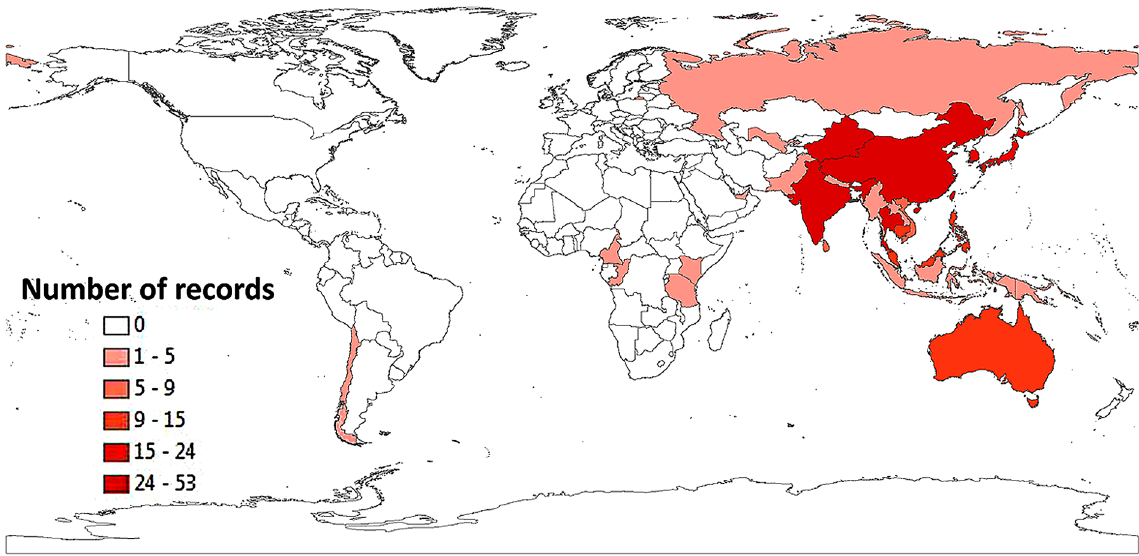
Fig 1. Map showing numbers of records by country of scrub typhus cases from the literature included in this